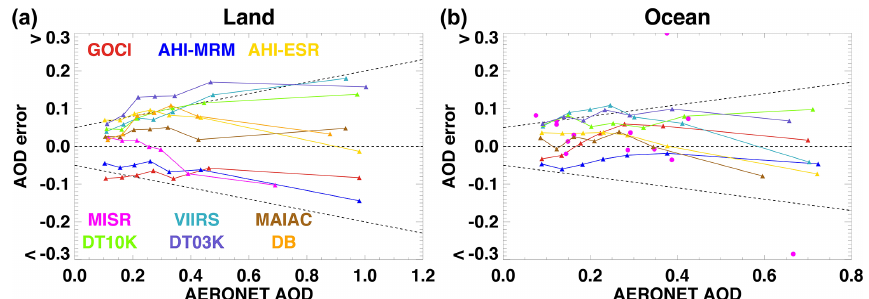
Figure 3. Comparison of observed (a) land and (b) ocean AOD errors for AERONET AOD. For each product, the total co-located data are grouped into seven bins according to AERONET AOD, except for MISR ocean AOD errors because of low co-location numbers. Each symbol indicates the median error for each co-located point, respectively. Black lines indicate zero difference and the EE DT range ± ( 0 . 05 + 0 . 15 × AOD AERONET ). Table 2. IR cloud masking processes of the AHI YAER algorithm. Note that “high latitude” in step 1 corresponds to the 1st, 2nd, 9th, and 10th segments from the north of the AHI observation segments (a total of 10 segments for the full disk area) and “midlatitude to low latitude” in step 1 corresponds to the other 6